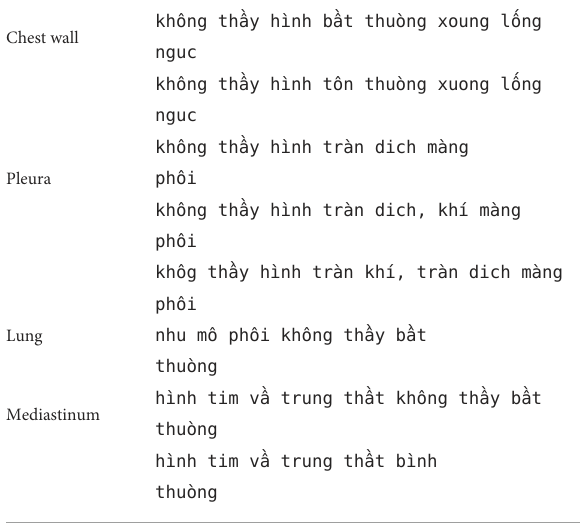
TABLE 2 Templates for normal descriptions of the four anatomical regions in a CXR radiology report. Anatomical Templates for normal region